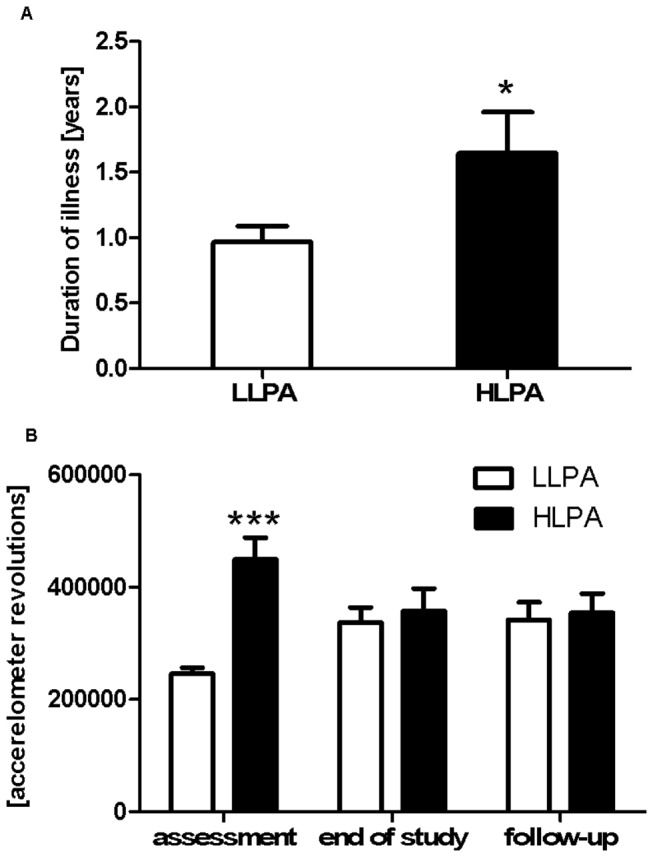
Characterization of LLPA and HLPA patients.A) Duration of illness, defined as time between obtaining the first diagnosis and initial assessment at Rintveld clinic. Duration of illness is significantly higher for the HLPA (high levels of physical activity) group than for the LLPA (low levels of physical activity) group. Mean±SEM, Student’s t-test, * P<.05. B) Physical activity of the LLPA and the HLPA groups at initial assessment, at the end of study, and at follow-up. Data are expressed as mean ± SEM; Repeated measures ANOVA, Student’s t-test as a post hoc test: *** P<.001 in comparison to the LLPA group at the same time point.